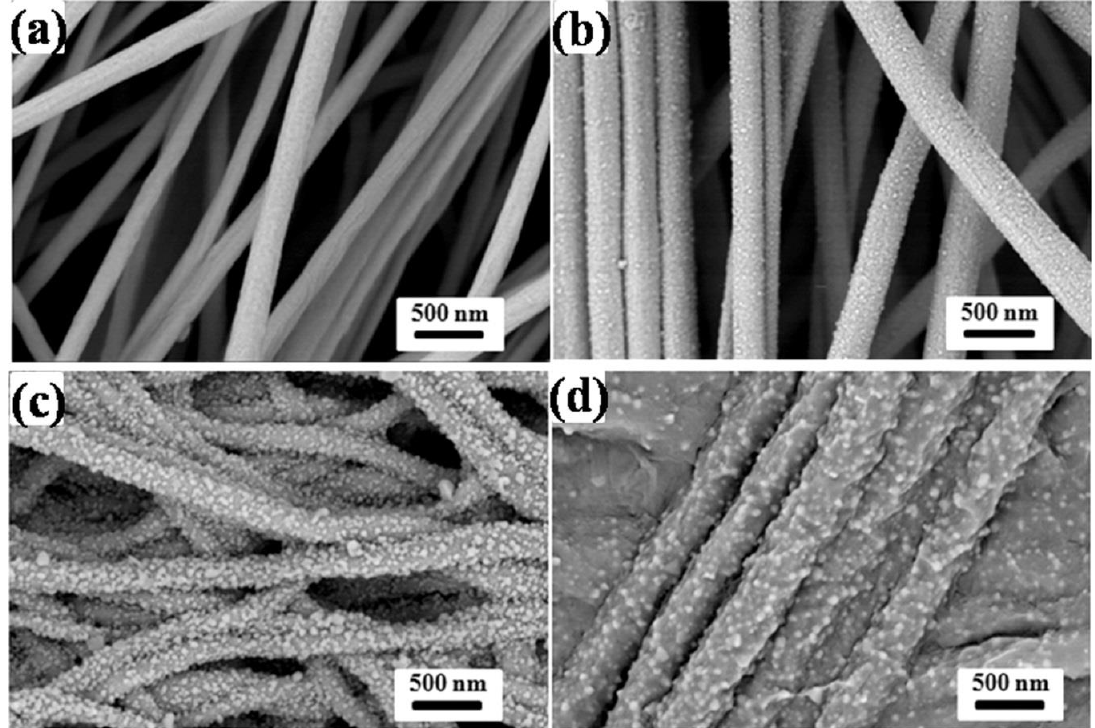
Figure 6. SEM images of ( a ) as-electrospun Na-alginate nanofibers and ( b – d ) Ag/alginate nanofibers obtained at different reduction times: ( b ) 10, ( c ) 20, and ( d ) 30 min. Reprinted with permission from Ref. [124]. Copyright American Chemical Society, 2018.